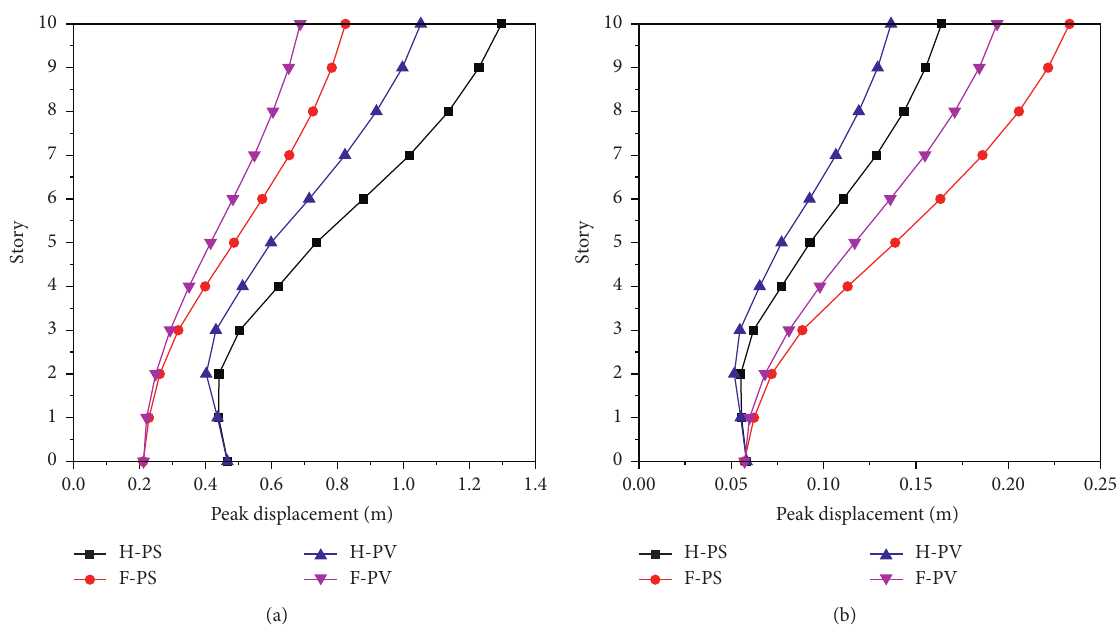
Figure 7: The average peak displacement of the structure under the hanging wall and footwall seismic excitations: (a) without amplitude modulation; (b) with amplitude